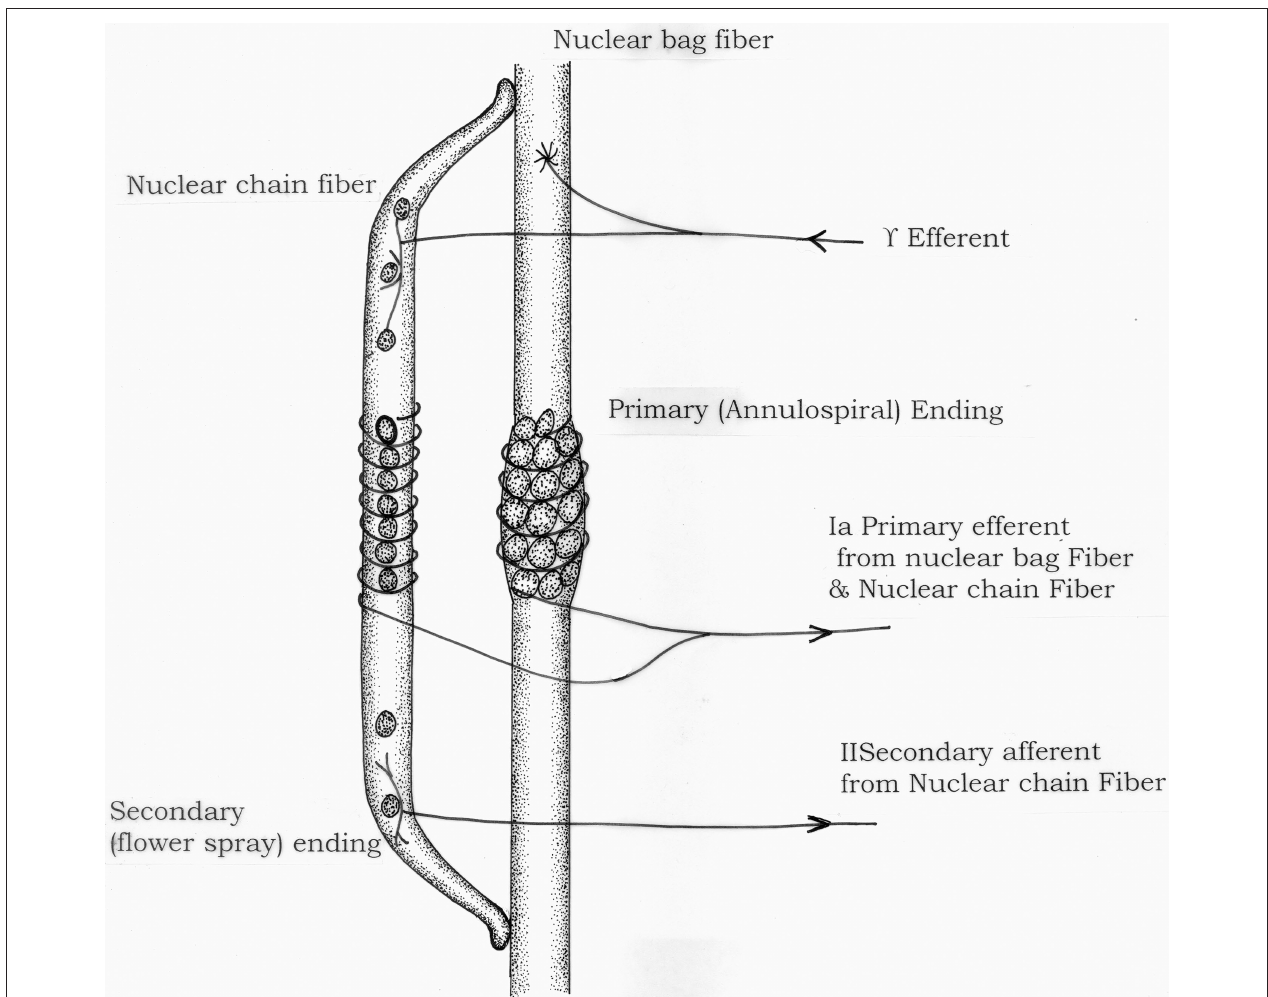
Figure 1 | Diagrammatic representation of muscle